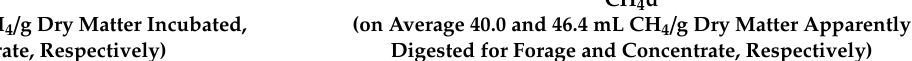
Table 7. Behaviour analysis 1 of the artificial neural network (ANN) and support vector regression (SVR) models.